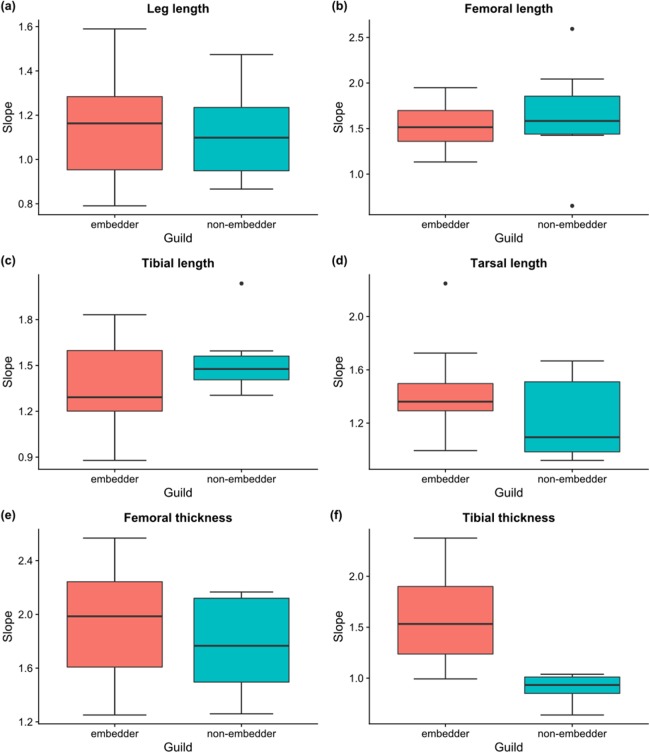
Boxplots of slopes of allometric relationships for hind leg traits for different feeding guilds.Boxplots of slopes (bMA) of allometric relationships for hind leg traits for embedders and non-embedders: (A) leg length, (B) femoral length, (C) tibial length, (D) tarsal length, (E) femoral thickness, (F) tibial thickness. Solid horizontal line indicates the median, and the lower and upper hinges correspond to the first and third quartiles, while the upper whisker extends to the largest value no further than 1.5 times the IQR (inter-quartile range), and the lower whisker extends to the smallest value 1.5 times IQR.